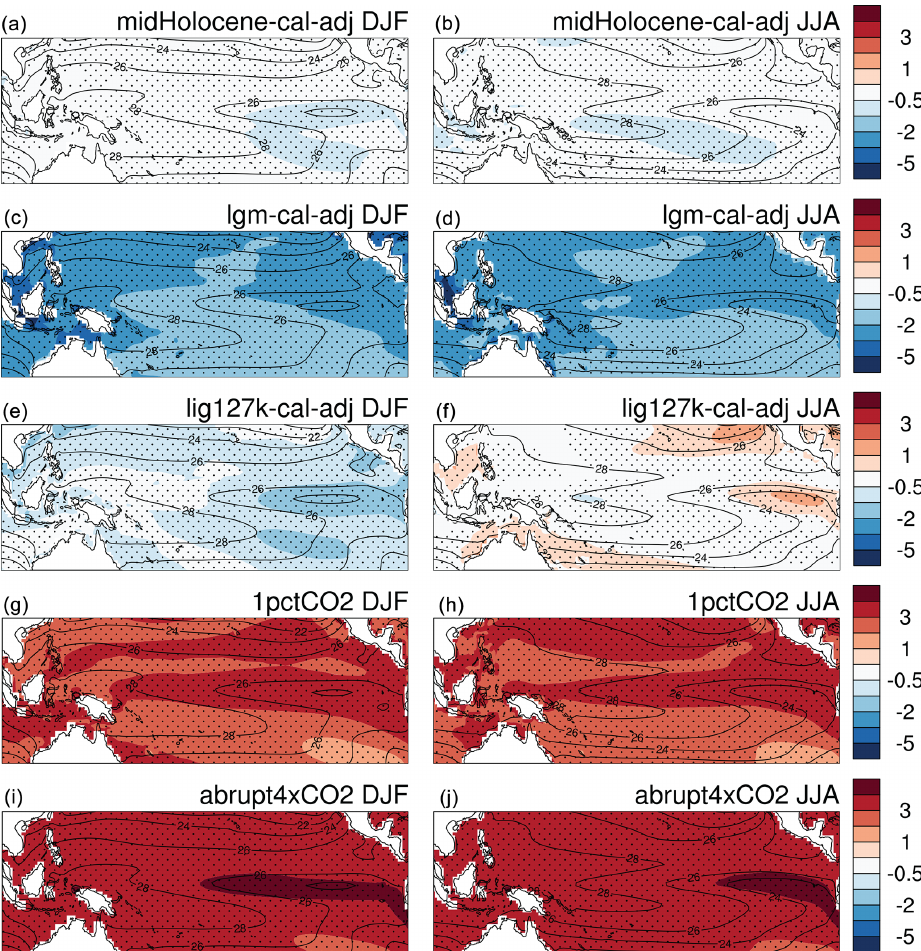
Figure 6. Ensemble mean seasonal changes in sea surface temperature in experiment minus pre-industrial control simulations: (a) DJF midHolocene , (b) JJA midHolocene , (c) DJF lgm , (d) JJA lgm , (e) DJF lig127k , (f) JJA lig127k , (g) DJF 1pctCO2 , (h) JJA 1pctCO2 , (i) DJF abrupt4xCO2 , and (j) JJA abrupt4xCO2 . The ensemble mean temperature pattern in the pre-industrial control simulations is shown as black contours. Units are ◦ C. Stippling indicates that more than two-thirds of the ensemble members agree on the sign of the